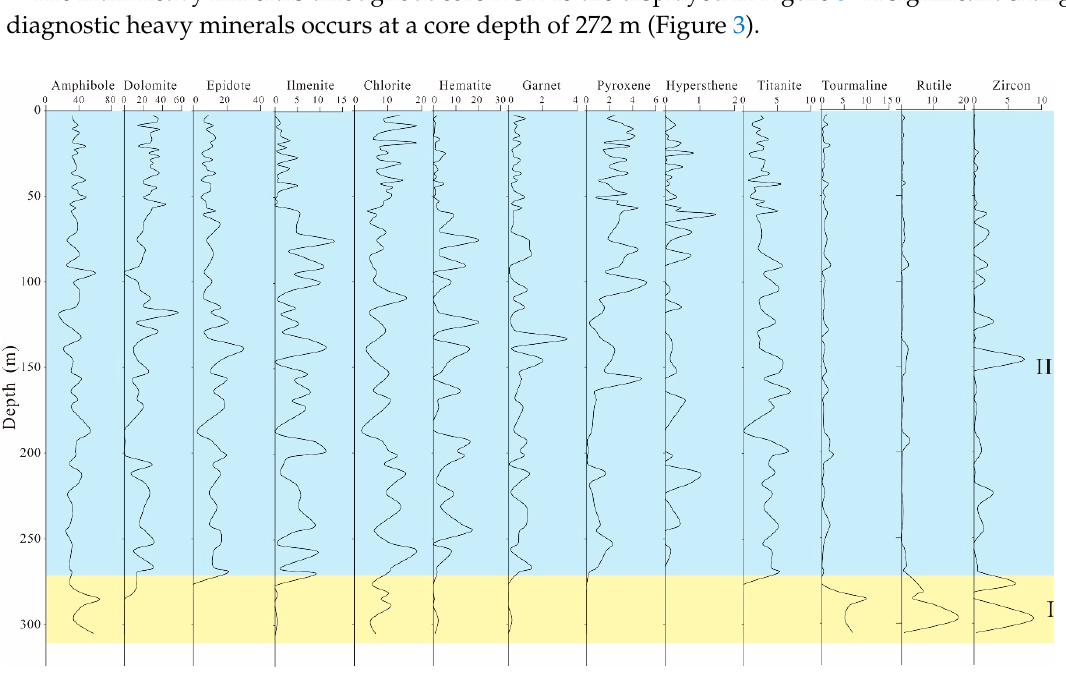
Figure 3. Heavy minerals of core RGK15. Two zones (Zone I of Pliocene and Zone II of Quaternary) can be identified.